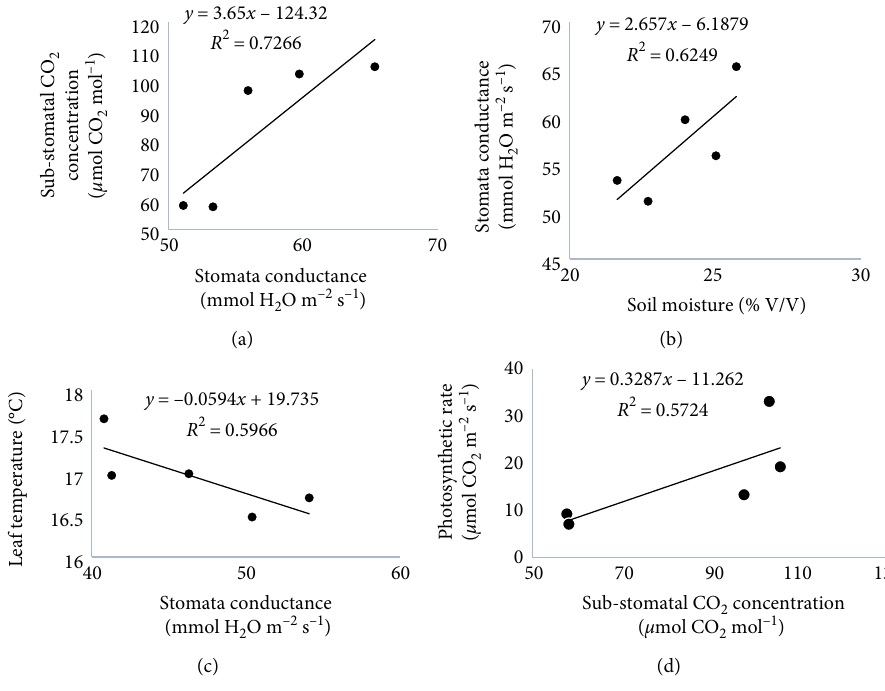
Figure 6: Correlations among leaf gas exchange parameters and soil